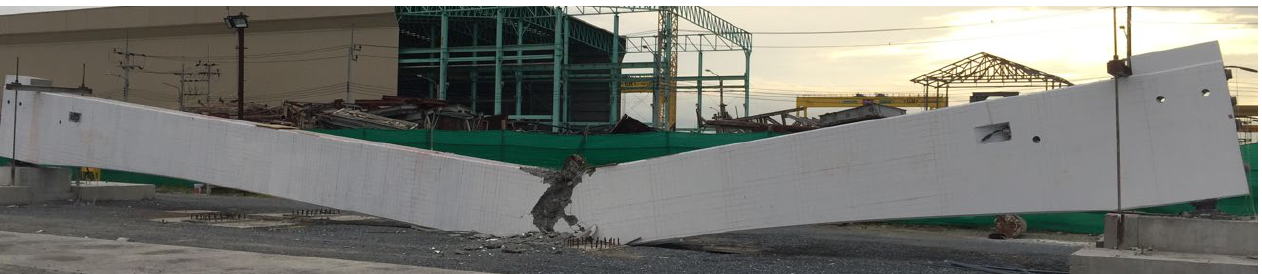
Figure 52. Ultimate failure of specimen SP-3.